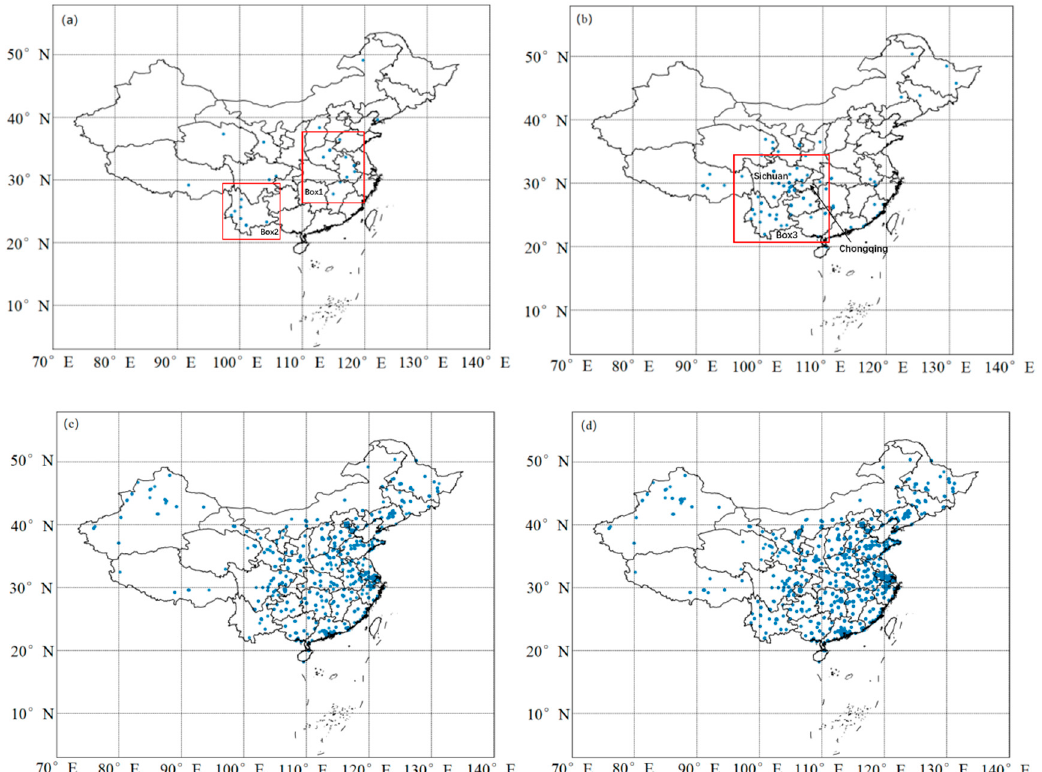
Figure 2. Site distribution with different correlation coefficient (CC) value ranges in China (red Box1, Central China; red Box2, Yunnan; red Box3, Southwest China): ( a ) |r| > 0.7; ( b ) 0.5 ≤ |r| < 0.7; ( c ) 0.15 ≤ |r| < 0.5; ( d ) |r| <